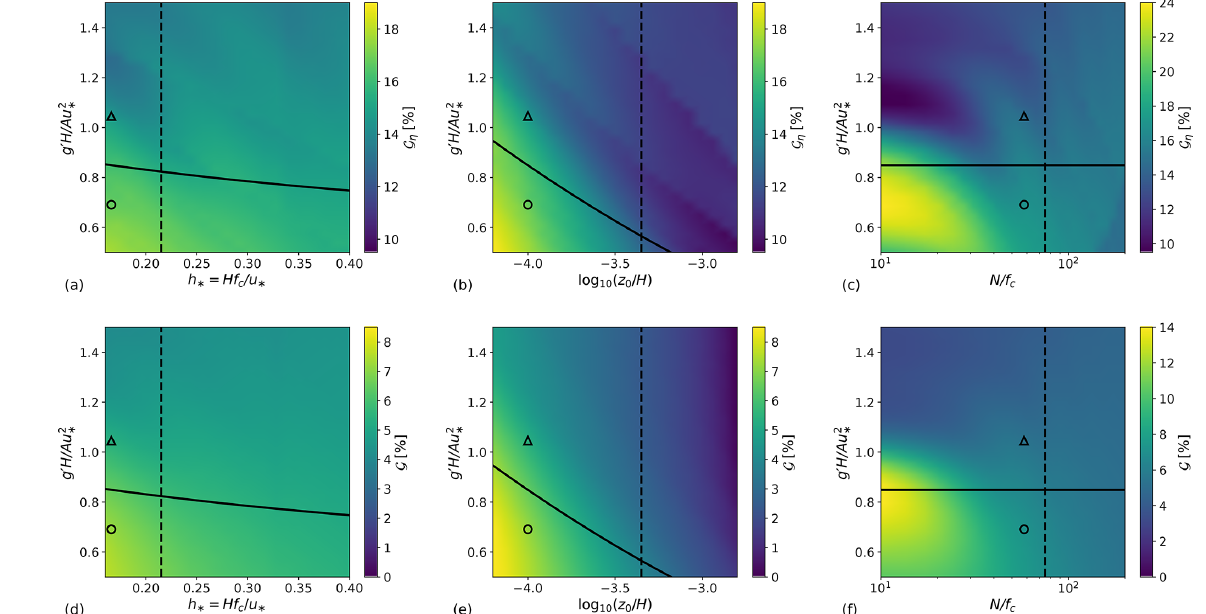
Figure 7. Sensitivity of (a–c) inversion-layer vertical-displacement reduction G η and (d–f) power gain G to atmospheric conditions. (a, d) Non-dimensional boundary layer height h ∗ (with z 0 = 10 − 4 and N/f c = 58), (b, d) logarithm of the non-dimensional surface rough- ness length z 0 (with h ∗ = 0 . 166 and N/f c = 58) and (c, f) ratio of Brunt–Väisälä frequency to Coriolis parameter N/f c (with h ∗ = 0 . 166 and z 0 = 10 − 4 ) against the inversion parameter g (cid:48) H/Au 2 ∗ . The black solid line corresponds to critical flow conditions ( Fr = 1) while the black dashed line corresponds to flow conditions of P N = 1 . 5. The markers (cid:52) and ◦ represent the sub- and supercritical flow case studied in Sect. 4.1, respectively. Note that (c) and (f) use a different scale than (a, b) and (d, e)